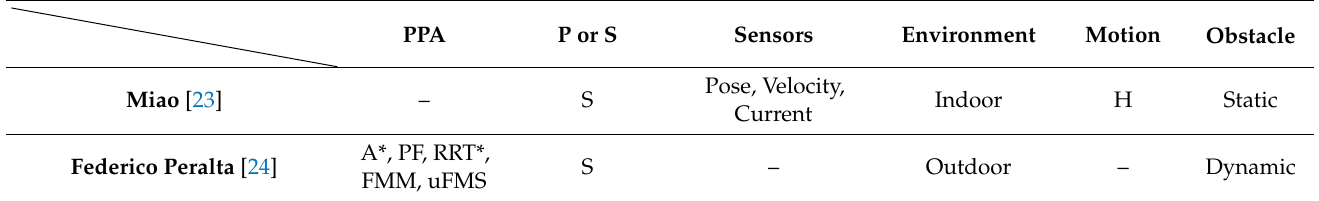
Table 1. Review of mobile robots and their path planning techniques, PPA: path planning